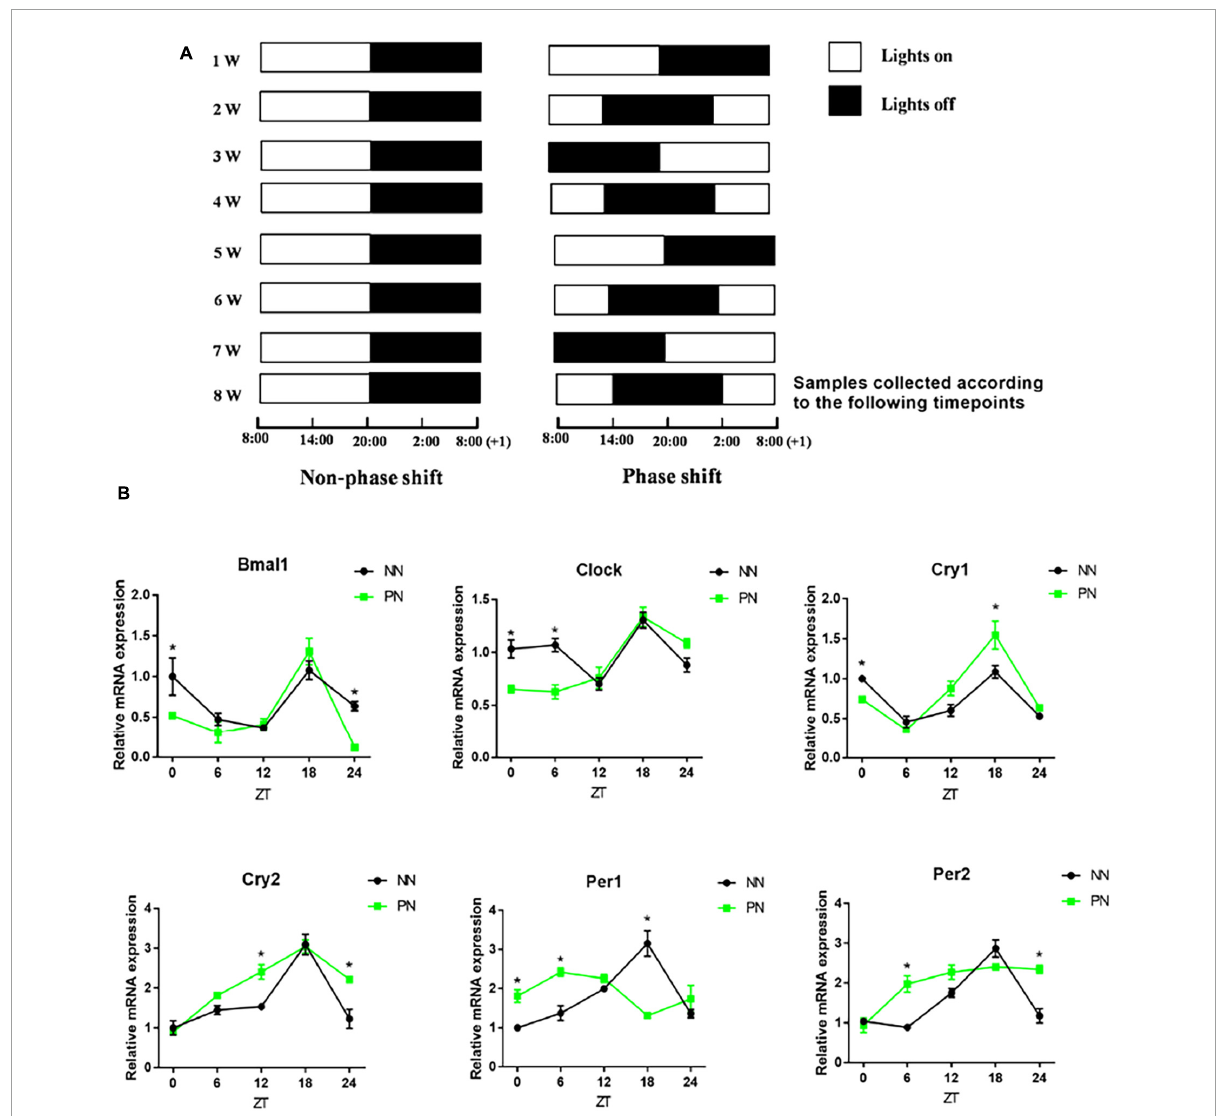
FIGURE1 Light/dark phase-shift model. NN and PN mice were kept in a self-made light-controlled feeding box for 8 weeks. (A) Lights were turned on and off every week at fixed time intervals in the NN group (Lights on at 8:00 a.m. and off at 20:00). The turning on and off of lights was delayed by 6 h per week in the PN group (Left, NN group; Right, PN group). (B) The mRNA expression of clock genes (Bmal1, Clock, Cry1, Cry2, Per1, and Per2) in the colon. Data are expressed as the mean ± SEM. Comparison between two groups performed with a two-tail Student’s t -test at each zeitgeber time. * P < 0.05. N = 30 per group, n = 6 per zeitgeber time. NN, Non-phase shift; PN, Phase shift; ZT, zeitgeber time; Bmal1, aryl hydrocarbon receptor nuclear translocator-like protein 1; Clock, circadian locomotor output cycles kaput; Cry1, cryptochrome 1; Cry2, cryptochrome 2; Per1, period circadian clock 1; Per2, period circadian clock 2.